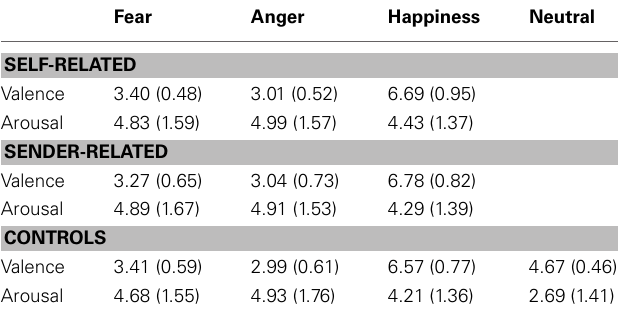
Table 1 | Experiment 1: rating data of emotional faces which were preceded by either self-related pronoun-noun pairs, sender-related pronoun-noun pairs, or no pronoun-noun pairs (control